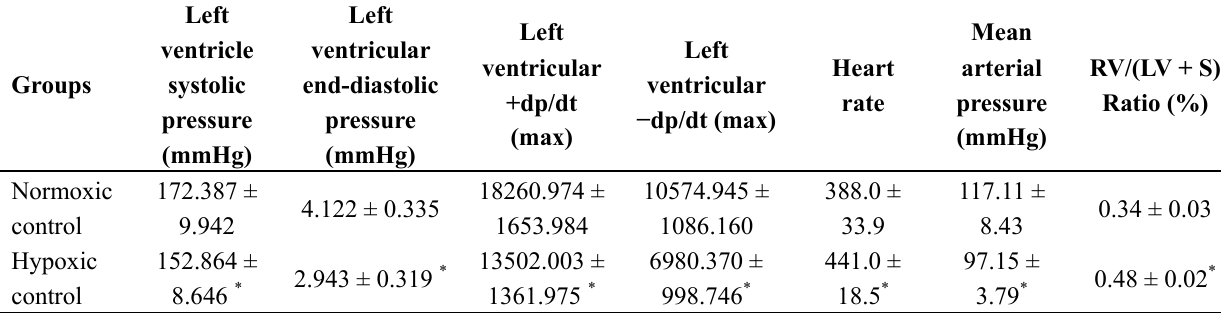
Table 3. Effect of total flavonoids of seabuckthorn on hemodynamic variables in high-altitude polycythemia